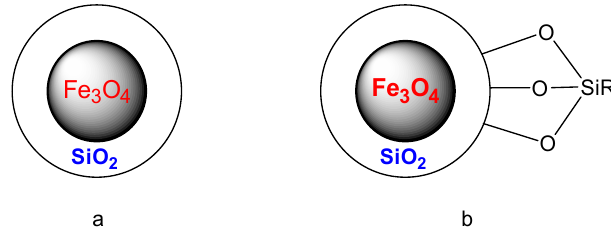
systems; and ( b ) the finer details of how the ligand that holds palladium in place is attached to the magnetic particle.